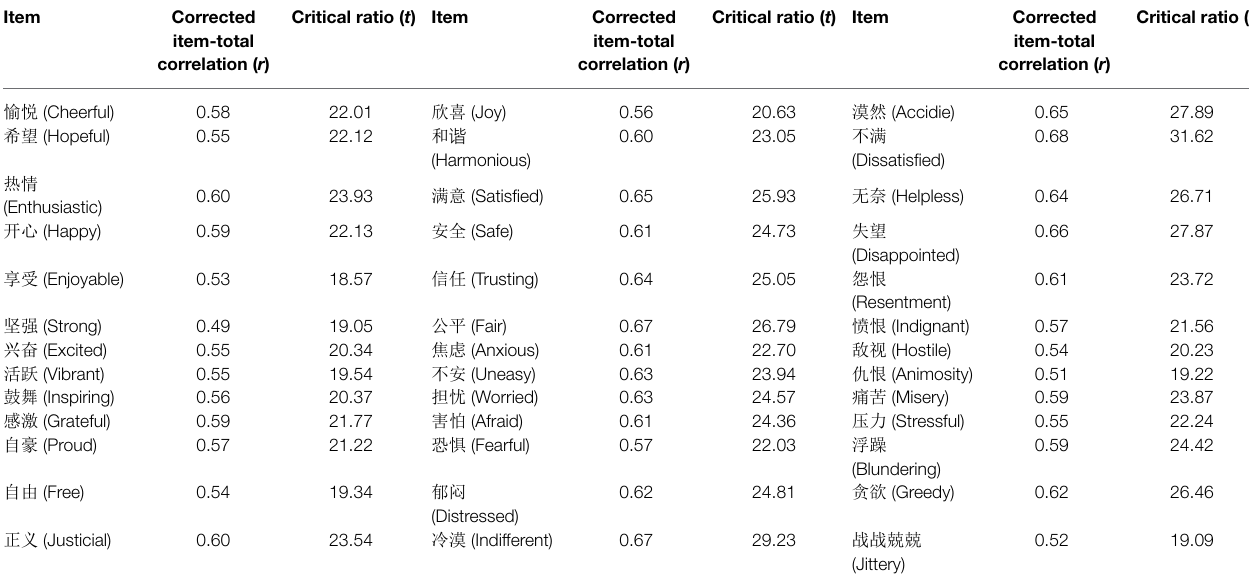
TABLE 2 | Corrected item-total correlation and critical ratio for the